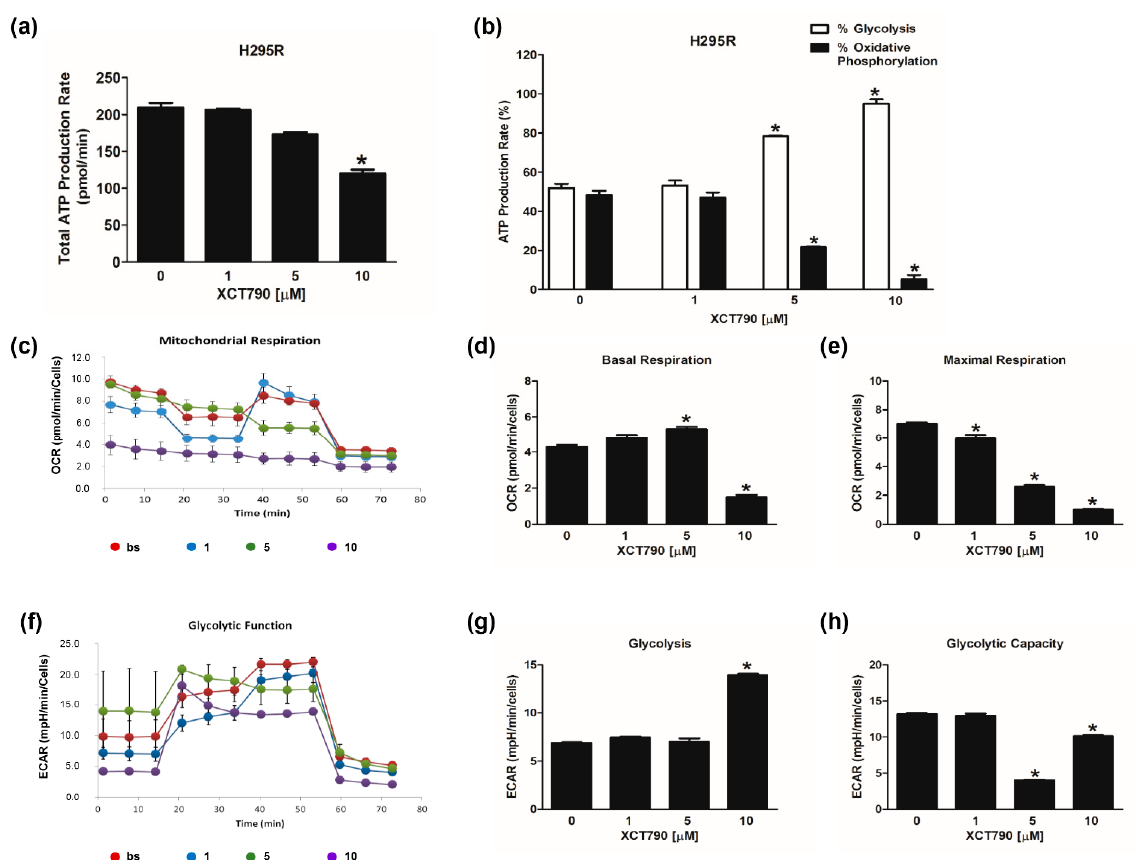
Figure 3. Effect of XCT790 treatment on H295R cell metabolism. The metabolic profiles of H295R cells untreated (0) or treated with XCT790 (1, 5, 10 µM) for 18h were assessed using the Seahorse XFe96 analyzer. ( a , b ) ATP Rate Assay was evaluated as indicated in “Materials and Methods”. Graphs represent the mean ± SD of three independent experiments of Total ATP Production Rate (pmol/min) ( a ) and ATP production (%) ( b ) derived from glycolysis and oxidative phosphorylation after the sequential addition of specific inhibitors; (* p < 0.05 vs. 0). ( c – e ) Mitochondrial Stress Analysis was performed as indicated in “Materials and Methods”. Graphs represent the mean ± SD of three independent experiments of real-time oxygen consumption (OCR) rate (pmol/min/cells); (* p < 0.05 vs. 0). Mitochondrial Respiration( c ), Basal Respiration ( d ), Maximal Respiration ( e ) were measured from OCR after the addition of specific inhibitors. ( f – h ) Glycolytic Stress Analysis was performed as indicated in “Materials and Methods”. Graphs represent the mean ± SD of three independent experiments of real-time extracellular acidification (ECAR) rate (mpH/min/cells); (* p < 0.05 vs. 0). Glycolitic function ( f ), Glycolysis ( g ) and Glycolytic Capacity ( h ) were measured from ECAR after the addition of specific